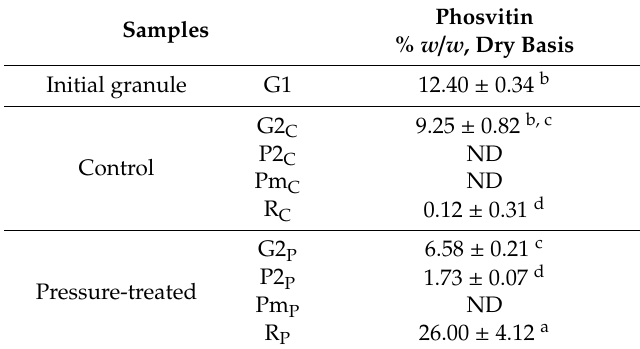
Table 3. Phosvitin content of control and pressure-treated fractions of egg yolk. Samples